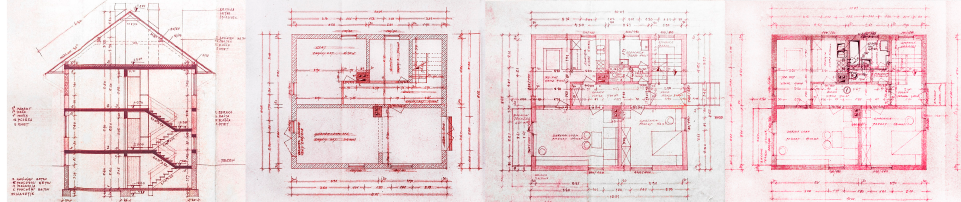
Figure 1. An example of a house located in Hrastje, Kranj, showing sections and floor plans—draw- ings collected on-site, donated by the owner. Obtained by Ana Bel č i č in